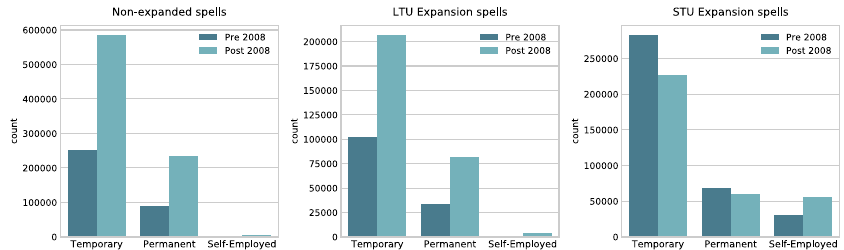
Fig. 11 Unemployment spells by expansion, before and after the 2008 Recession. Source : MCVL. Raw number of unemployment spells, by unemployment expansion and contract type. Pre 2008: 2004–2008. Post 2008: 2009–2013